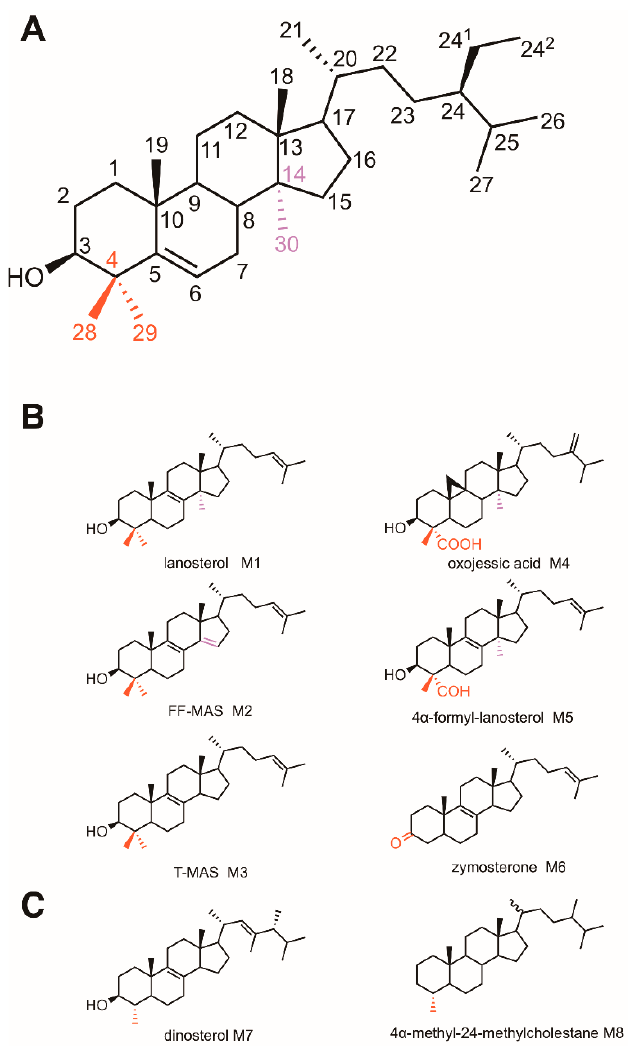
Figure 1. Sterol and 4-methylsterol structures. ( A ) carbon numbering. ( B ) some compounds described in this article. ( C ) dinosterol and a sterane, a biogeological marker.